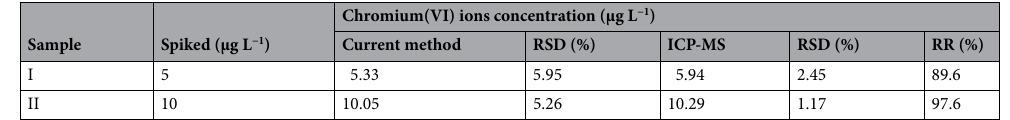
Table 1. Analysis of water samples spiked with Cr(VI) ions using adsorptive colorimetry and ICP-MS method.